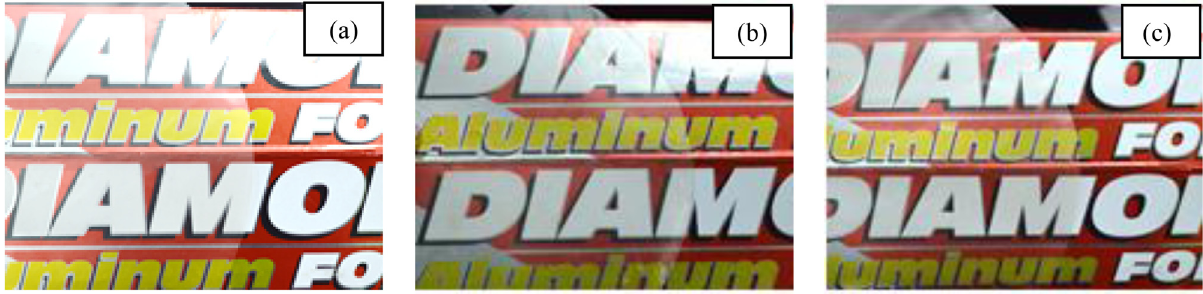
Figure 5: Physical appearance of the fi lms: ( a ) neat starch fi lm, ( b ) 15% w/w starch/CNP fi lm, and ( c ) 30% w/w starch/CNP fi